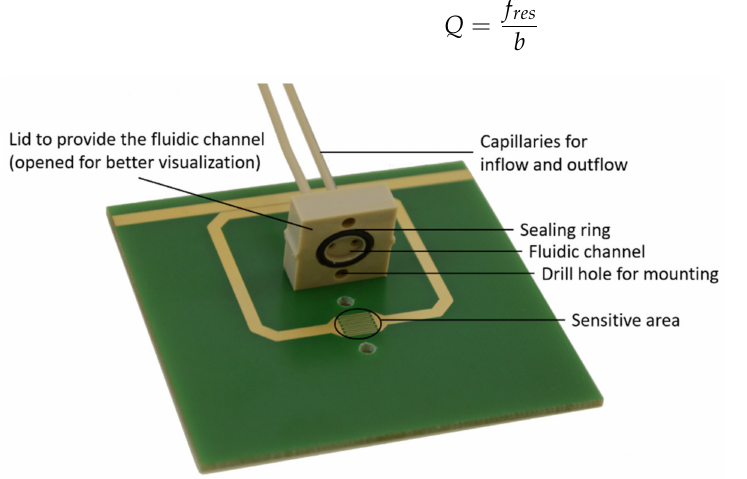
Figure 2. Split-ring resonator consisting of an FR4 printed circuit board with two microstrip lines (the top one for transmitting the wave and the other one is the split-ring micro strip line with the split as interdigital structure as sensitive area) and solder mask with open lid (for better